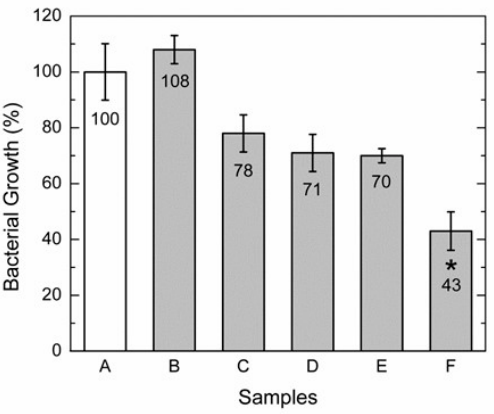
Figure 8. Staphylococcus aureus growth inhibition evaluation after 2 h at 37 °C. ( A ) Control without membrane. ( B ) Commercially available bacterial cellulose membrane. ( C ) (PVOH/GG/CA) (5/2 0.7) ( w / w ) % membrane with citric acid; 0% AZO-Np. ( D ) (PVOH/GG/CA) (5/2/0.7) ( w / w ) % membrane (the same sample as in ( C )) with thermo-chemical alkaline treatment; 0% AZO-Np. ( E ) (PVOH/GG/CA/AZO-Np) (5/2/0.7/2) ( w / w ) % membrane with citric acid; 2% AZO-Np. ( F ) (PVOH/GG/CA/AZO-Np) (5/2/0.7/2) ( w / w ) % membrane (the same sample as in ( E )); after alkaline treatment, 2% AZO-Np. Bars represent means, with vertical lines indicating standard deviations, * statistically significant difference when compared to control sample, n = 4, p ≤ 0.01. The sample with (PVOH/GG/CA/AZO-Np) (5/2/0.7/2) ( w / w ) %, 2%